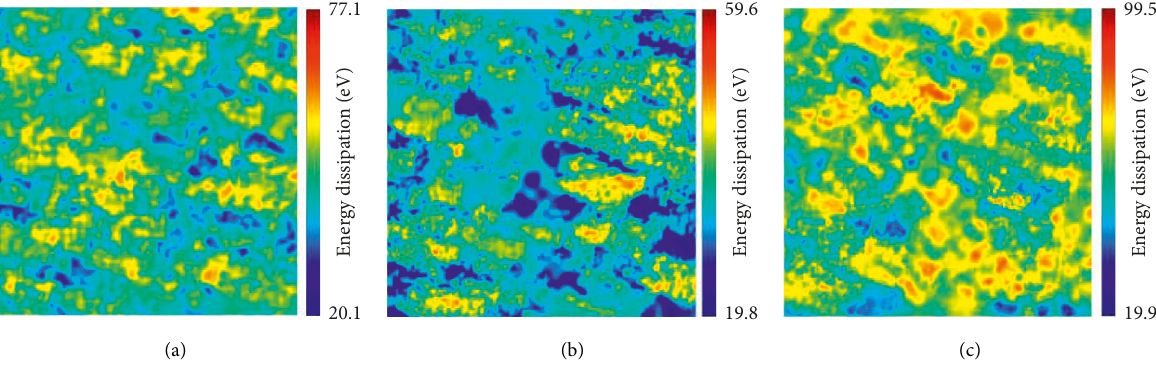
Figure 3: 2D maps of energy dissipation with a scanning size of 400 × 400 nm 2 for (a) ZrCuAl, (b) ZrCuAlNb, and (c)